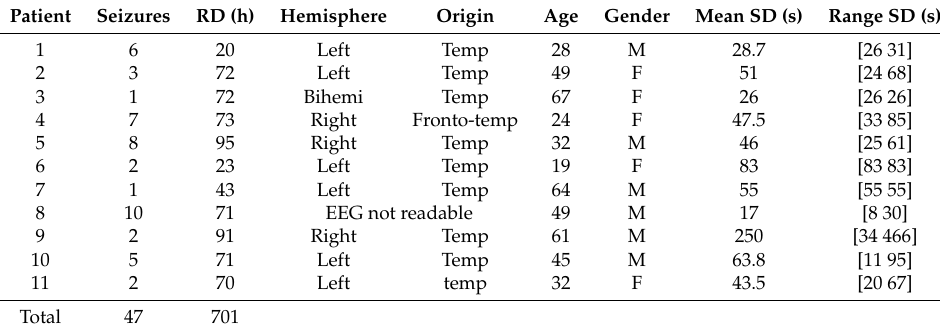
Table 1. An overview of the dataset, RD = Recording Duration, SD = Seizure